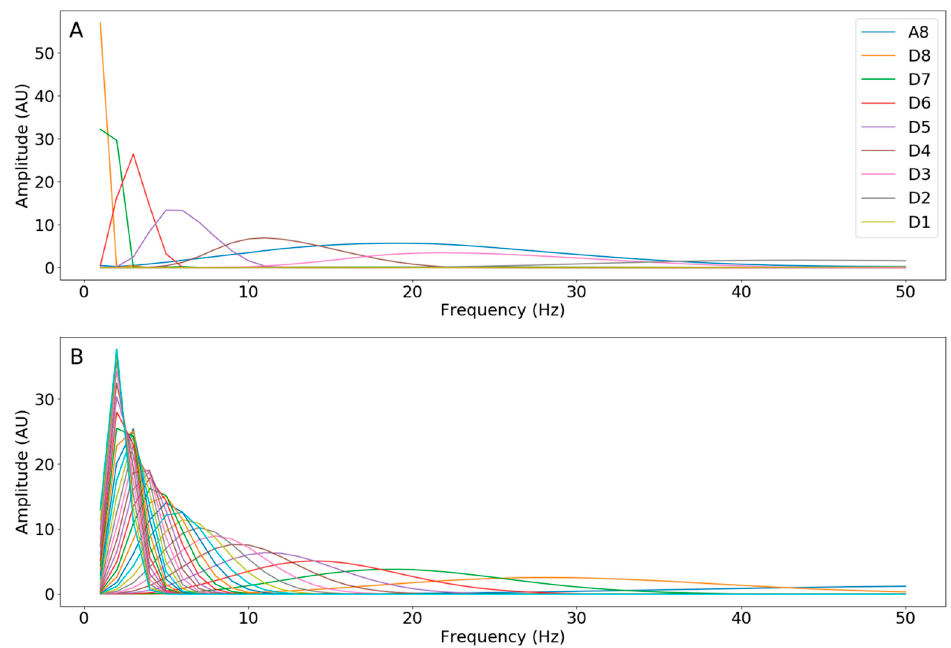
Figure A13. Frequency response for 1, 2, 3, …, 50 Hz. ( A ) The Daubechies wavelet (db4) with eight levels. ( B ) The Ricker wavelet with widths of 1, 2, 3, …, 30, where the maximum of each corresponding band has a frequency that decreases with increasing width.